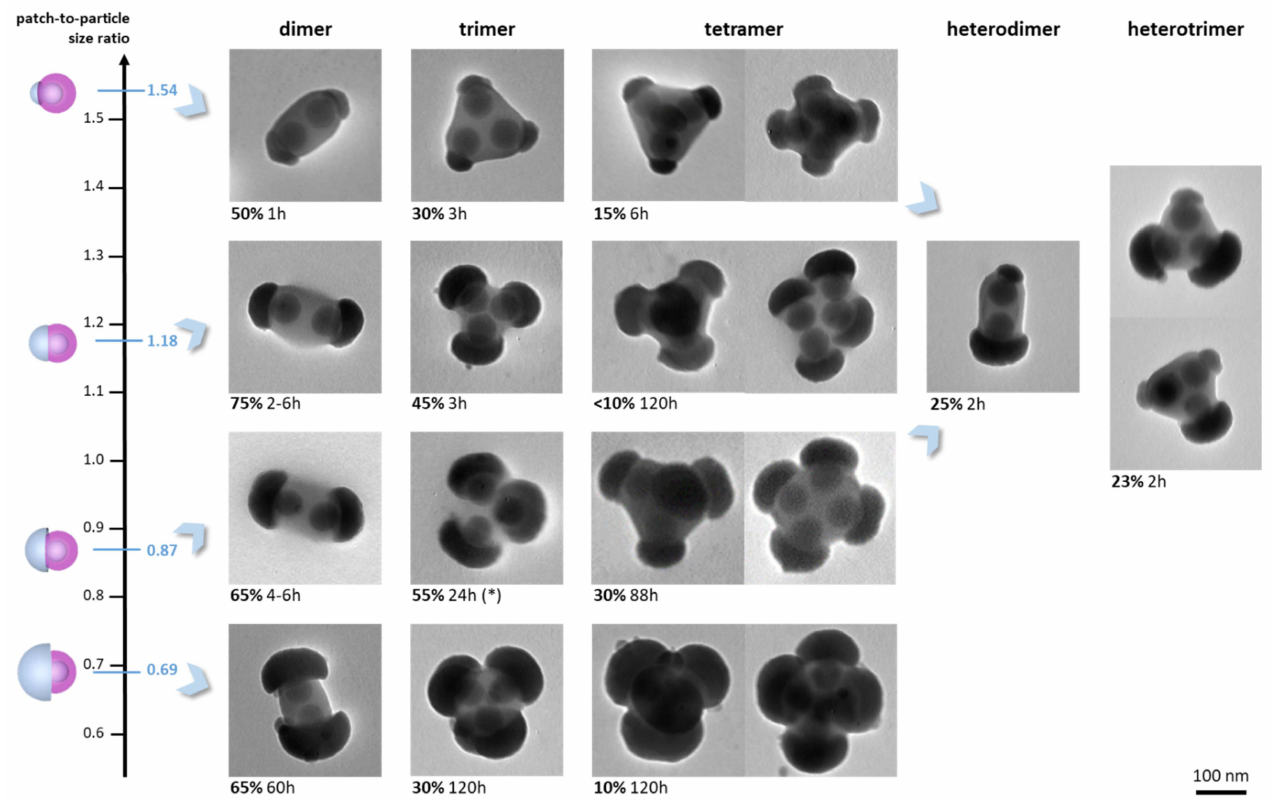
Figure 6. Representative TEM images of the dimers, trimers, and tetramers obtained from one-patch silica nanoparticles by the solvent-induced assembly. The optimum morphology yield and the incubation time after which it was observed (cf. Figure 4) are indicated, excepted for the trimers (*), which were optimized by the sequential addition of monomers (cf. Figure 5). Experimental conditions: equivolume THF/ethanol mixture; silica particle concentration, 1.8 × 10 14 L − 1 ; temperature, 20 ◦